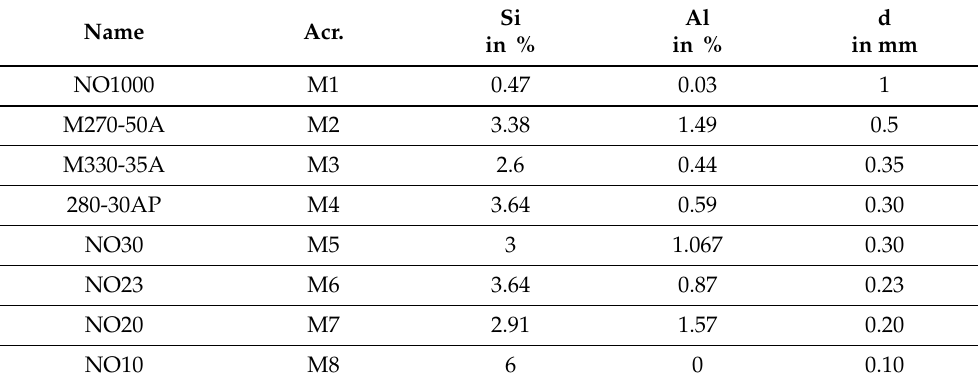
Table 1. Alloy weight content and nominal thickness of studied